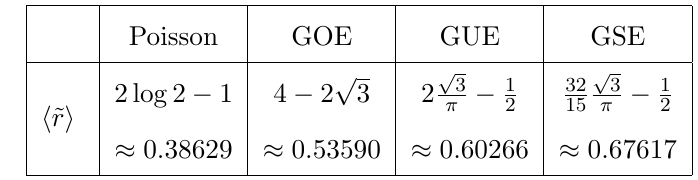
Table 1 . The mean value of ~ r -parameter for Poisson, GOE, GUE and GSE.